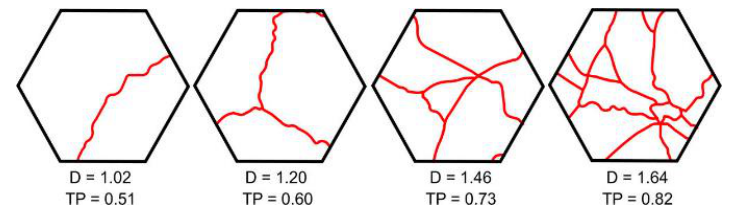
Figure 7. Fractal dimensions and transport utilization rates for different road patterns.